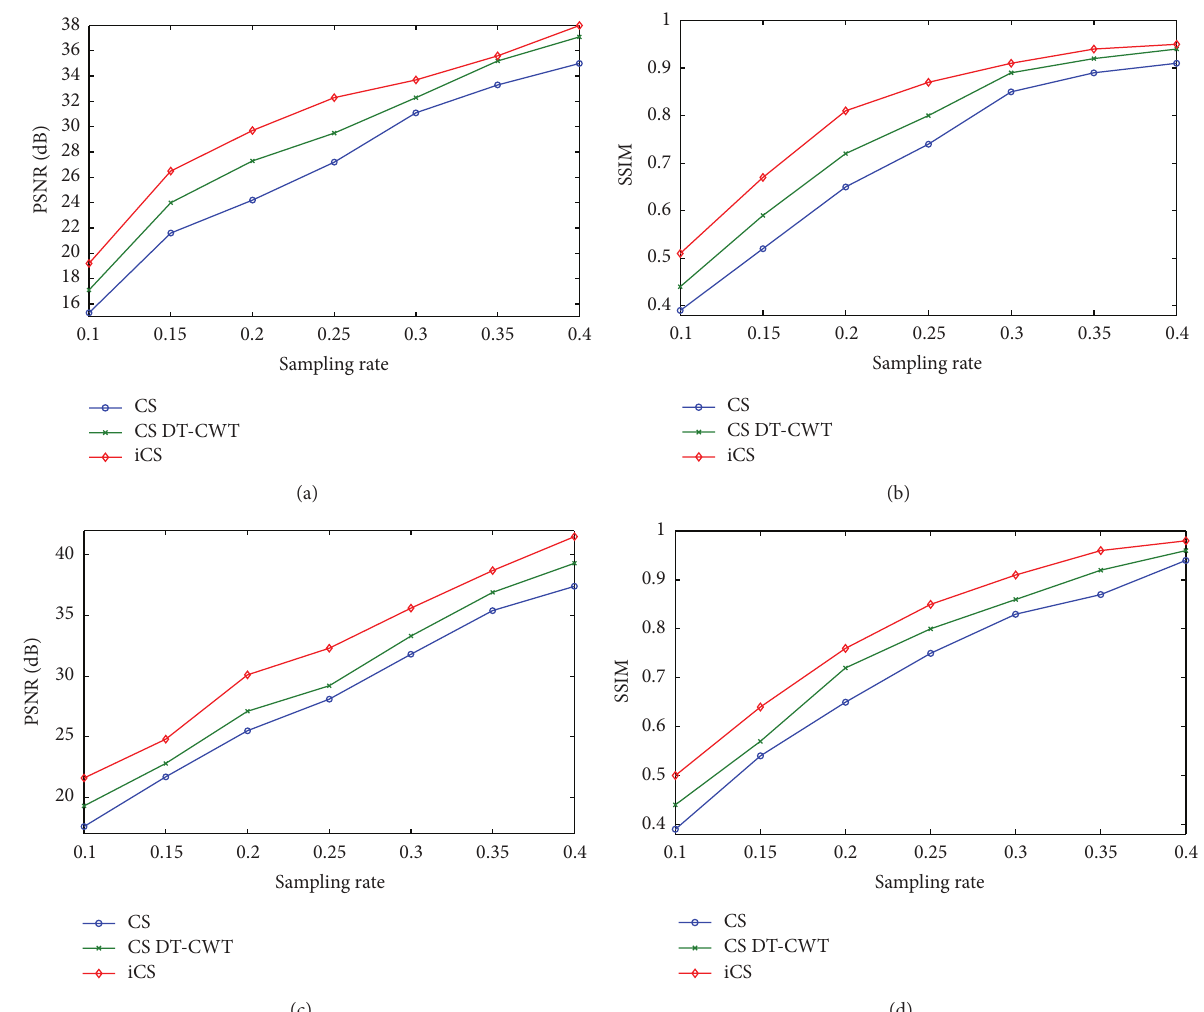
Figure 12: Plots of PSNR and SSIM for different sampling rates: (a)-(b) axial brain; (c)-(d) coronal